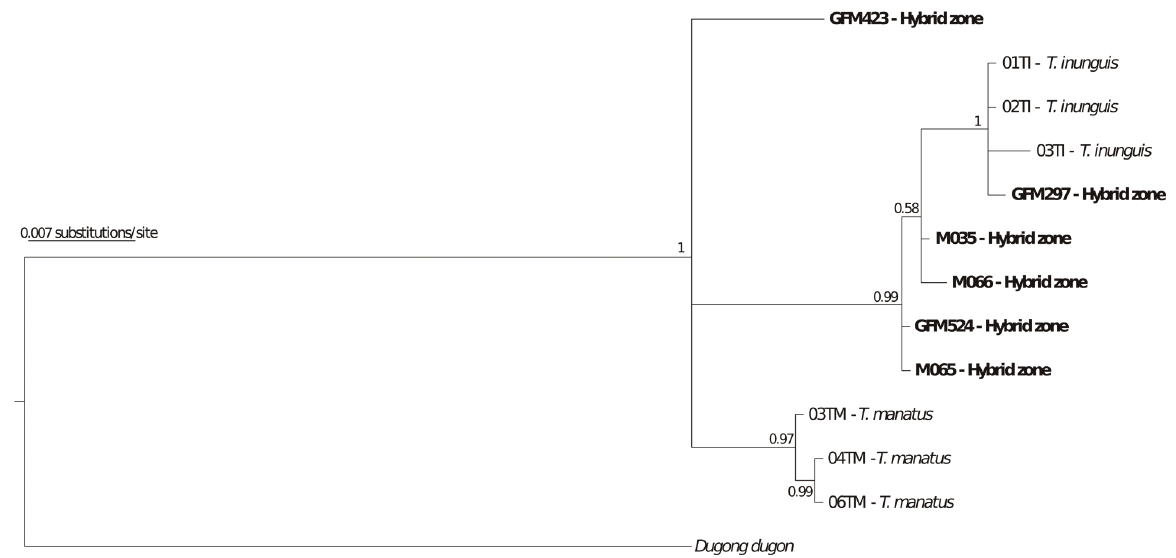
Figure 3 - Phylogenetic consensus tree of concatenated CR and RAg1 fragments of T. manatus , T. inunguis and interspecific hybrids (bold), using Dugong dugon as the outgroup. On the node labels are the posterior probabilities (PP) of each